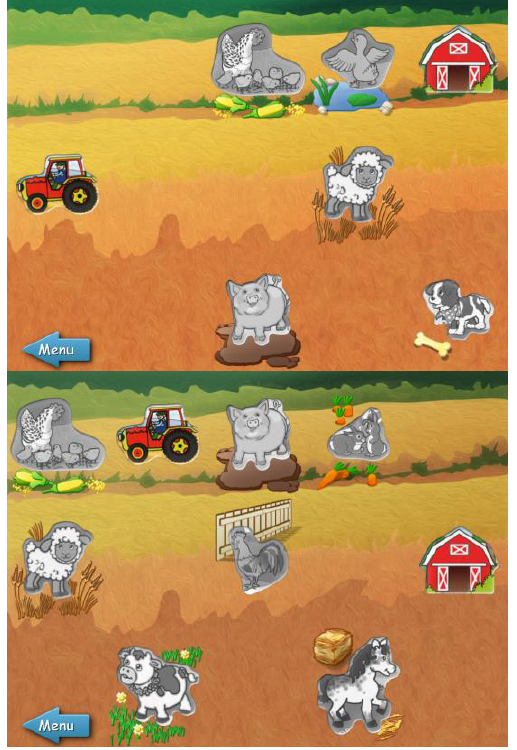
Figure 6. An indicative instance of the first level (Up) / An indicative instance of the second level (Down)